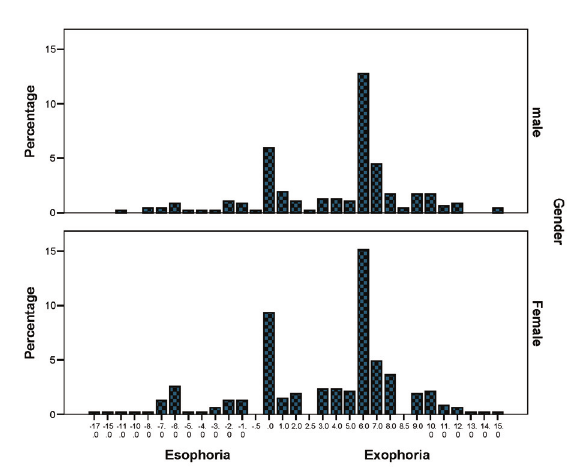
Figure 6 Distribution of near horizontal heterophoria accord- ing to gender. A large proportion (both males and females) is exophoric with a peak at 6 pd